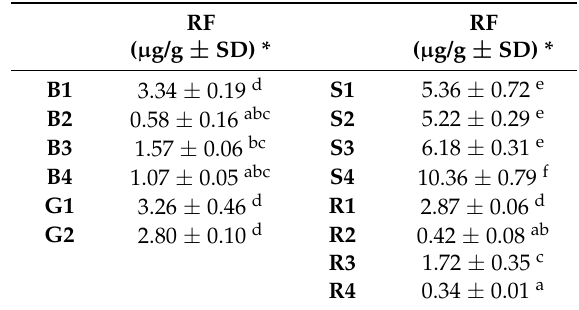
Table 1. RF content of tea infusions ( B: Black, G : Green, S : Sage, R : Rosemary).